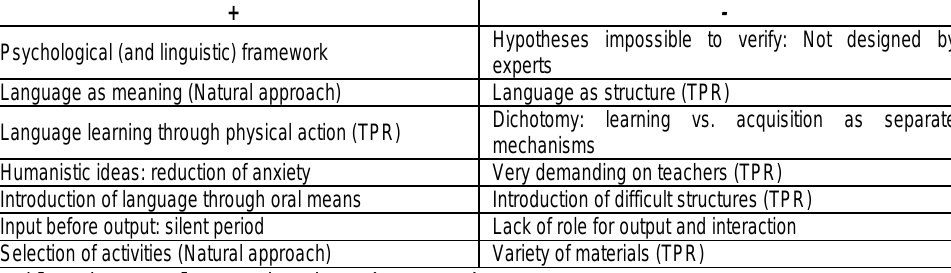
Table 7: the Natural approach and TPR in